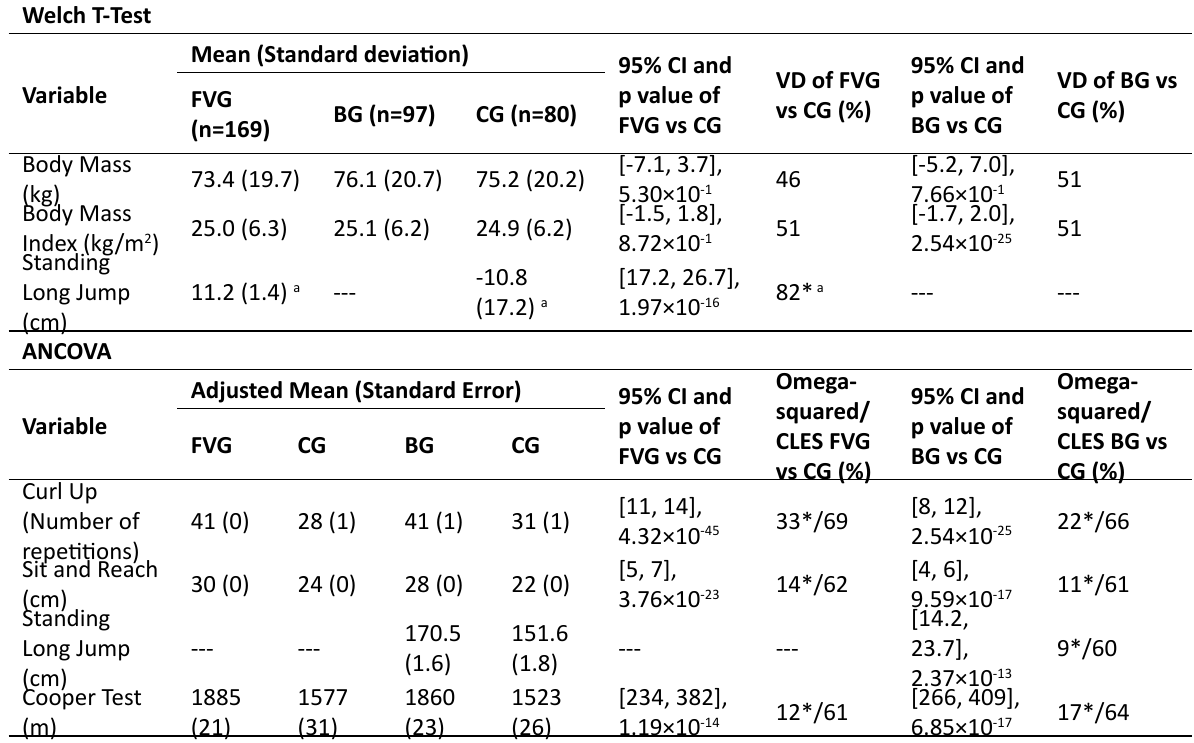
Table 3. Differences between exercise groups and control group Welch T-Test